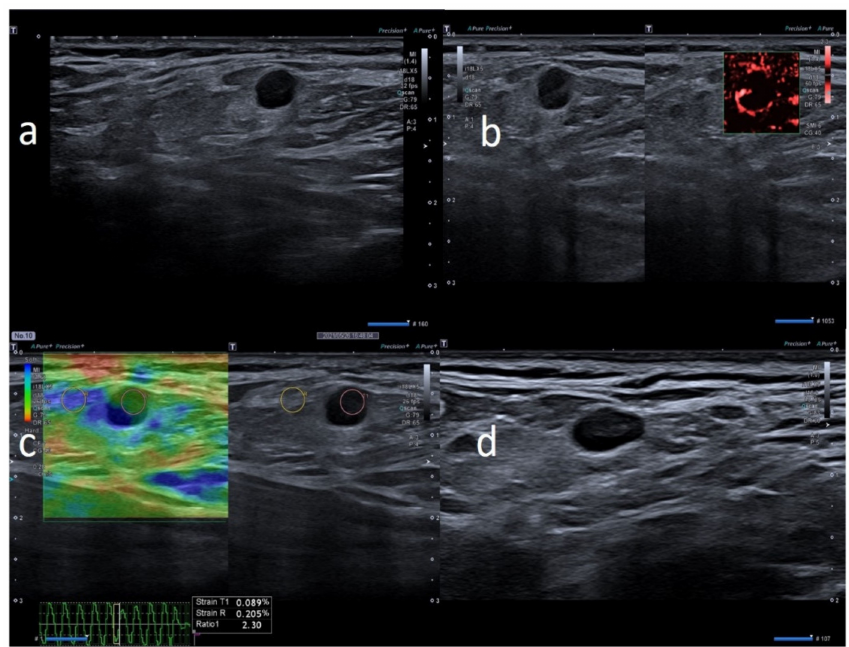
Figure 3. 74-year-old female with palpable unilateral sopraclavicolar adenopathy noted 2 days after receiving the first dose of the AstraZeneca COVID-19 vaccine in her left deltoid muscle. ( a ) B- mode sonogram image shows round, hypoechoic lymph node with hilum absence. ( b ) SMI images shows peripheral vascularization. ( c ) Elastosonography strain shows the hard pattern of the node surrounding tissue. ( d ) After 1 month, the cortical thickening appears uniform, with hilum evidence and normal vascularization.